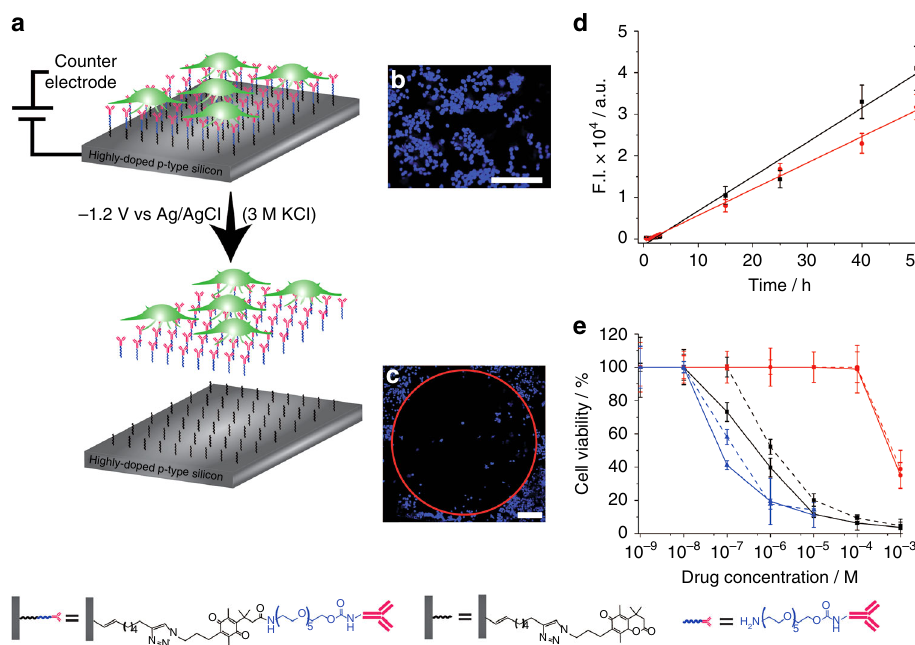
Fig. 2 Ensemble electrochemical release of cells and their viability. a Cell capture & electrochemical release of all adherent cells. b MCF-7 cells captured on an anti-EpCAM-modi fi ed p-type silicon surface (0.001 – 0.003 Ω cm), modi fi ed as shown (bottom left), and stained with Hoechst 33342 (blue). c The MCF-7 cells from b were removed from the central region where an o-ring con fi ned the electrolyte (DMEM with 10% foetal bovine serum) to this region. MCF-7 cells outside of this region were not exposed to the electrolyte and were therefore not released from the surface. Scale bars = 200 µ m. d Respiration, measured with alamarBlue ® , of captured & released MCF-7 cells over 50 h (red circles and lines), compared to an identical number of cultured MCF-7 cells (black squares and lines). e Cell viability and response of captured & released MCF-7 cells (dotted lines) and cultured MCF-7 cells (solid lines) to doxorubicin hydrochloride (blue lines), 5- fl uorouracil (black lines) and capecitabine (red lines). Error bars indicate margin of errors at 95% con fi dence, n